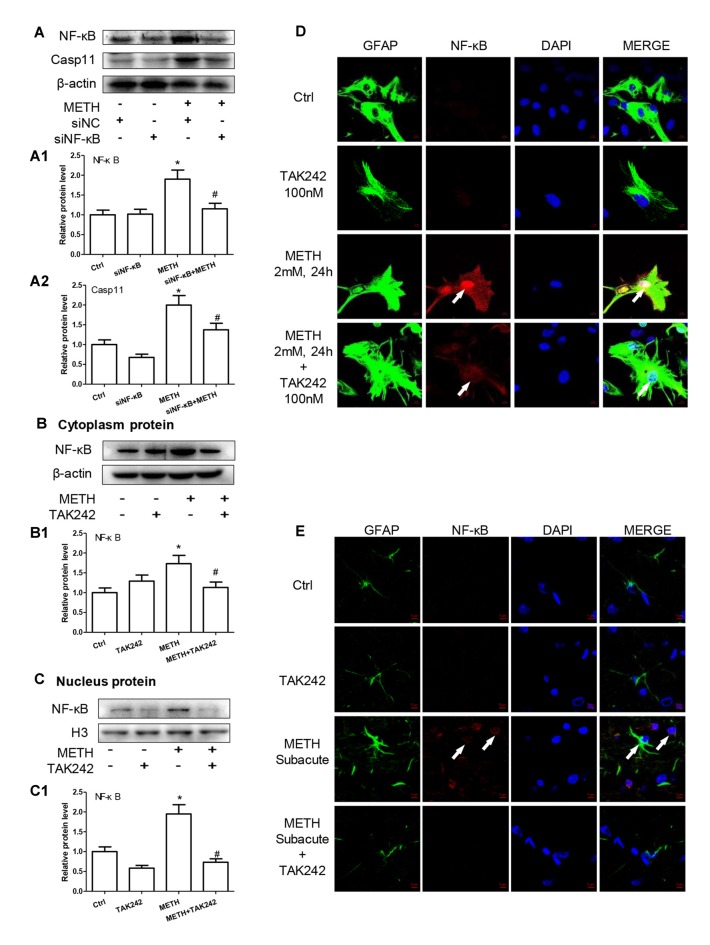
TLR4 induces translocation of NF-κB into the nucleus, leading to an increase of Caspase-11 transcription in METH-exposed astrocytes. (A–A2) Primary cultured astrocytes were transfected with siRNAs targeting NF-κB or control siRNA for 24 h followed by METH (2 mM) treatment for 24 h. (B–D) Cells were exposed to TAK-242 (100 nM) for 2 h prior to METH (2 mM) treatment as indicated, nucleus proteins (C,C1) and cytoplasm (B,B1) proteins were extracted separately. Western blot (A–C) and quantitative analyses were performed to determine NF-κB, and Caspase-11 protein expression. H3 was used as the loading control of nucleus proteins. Immunolabeling and confocal imaging analysis (D) showed elevated NF-κB expression in the METH-treated cells compared with controls. (E) The animal exposure paradigms were the same as described in Figure 4. Immunolabeling and confocal imaging analysis showed elevated NF-κB expression in the midbrain of METH-exposed mice compared with controls. White arrow refers to NF-κB. Cell experiments were repeated three times. Data are expressed as mean ± SD. *p < 0.05 vs. non-METH-treated group. #p < 0.05 vs. the scrambled + METH treated group. Data were analyzed with 2 × 2 factorial ANOVA followed by LSD post hoc analyses.